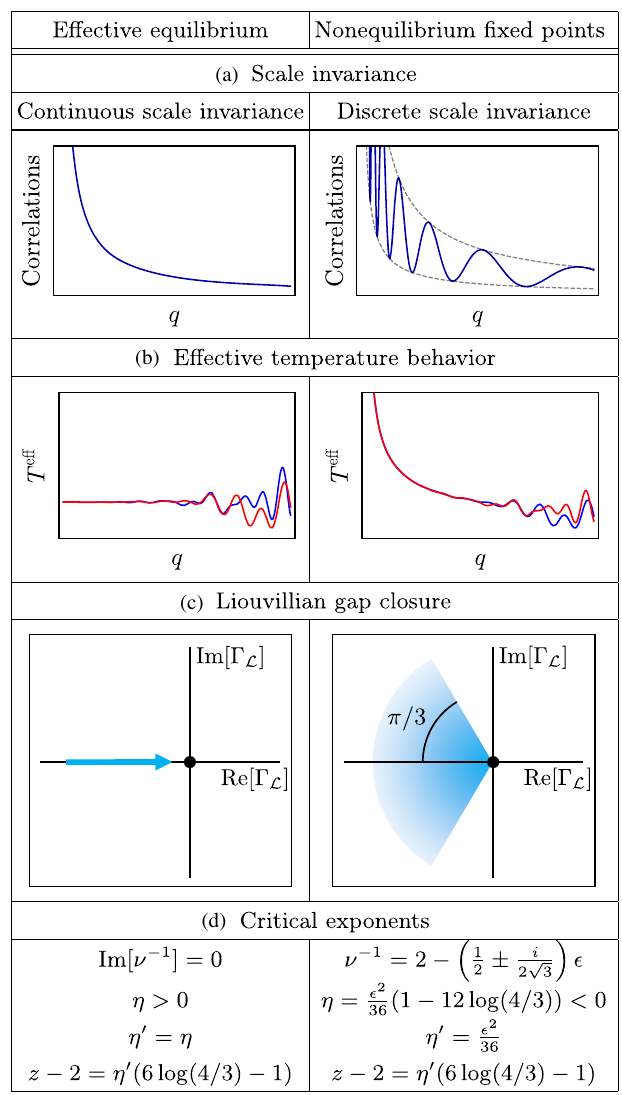
FIG. 3. Summary of the main features of the NEFPs contrasted with effective equilibrium fixed points. (a) Schematic correlation functions. A generic continuous scale invariance characteristic of criticality is reduced to a discrete scale invariance at the NEFP. (b) Effective temperatures T i representing the two order parameters as a function of the length scale ( q − 1 ). The two temperatures become identical at long length scales, but while they approach a constant at the equilibrium fixed point, they diverge at large scales at the NEFPs. (c) Gap closure upon approaching the critical point. Here, Γ L denotes the Liouvillian gap with the real part describing the relaxation rate (a.k.a. the dissipative gap) and the imaginary part characterizing the “ coherence gap. ” For the equilibrium fixed point, the gap can close only along the real line, indicated by the arrow. In contrast, the gap for the NEFP can take complex values and close along any path lying in the shaded region, making a maximum angle of π = 3 with the real line. (d) Critical exponents to lowest nontrivial order in ϵ ¼ 4 − d . The exponent ν , typically associated with the divergence of the correlation length, becomes complex valued at the NEFPs, with its imaginary part characterizing the discrete scale invariance [cf. part (a)]. Here, η and η 0 are anomalous dimensions characterizing fluctuations and dissipa- tionwith η ≠ η 0 attheNEFPsindicatingtheviolationofthefluctuation- dissipation theorem. Note that z is the dynamical critical